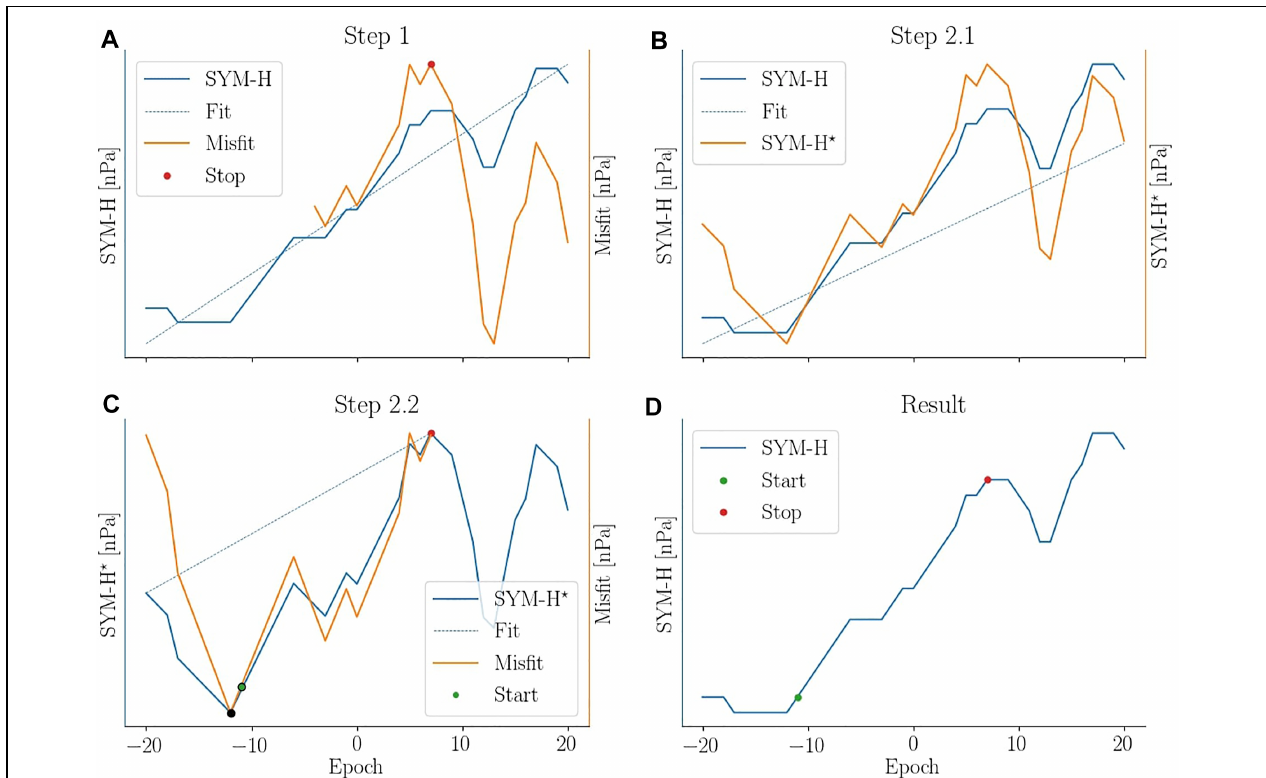
FIGURE 4 | Example of algorithm used to find the onset of the response in SYM-H. In (A) the peak of the response is found. In (B) the SYM-H response is detrended. In (C) the onset if located. (D) shows the estimated onset and peak of the SYM-H